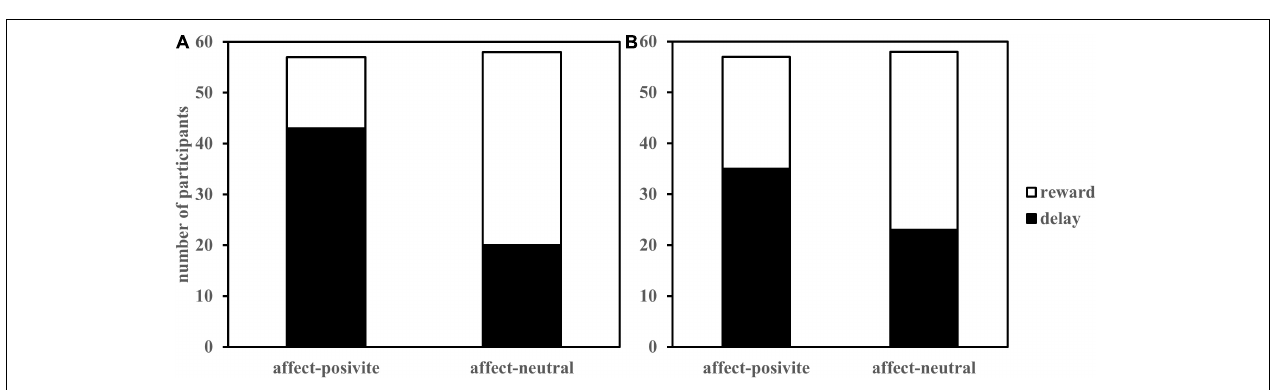
FIGURE 7 | Proportion of SS option in different groups (M ± SE) .